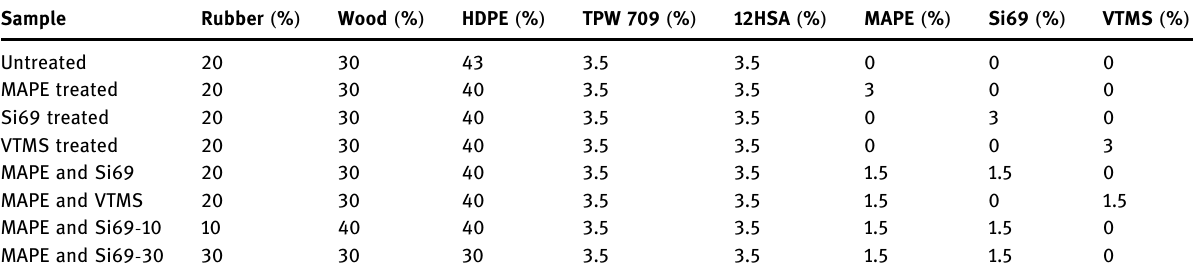
Table 1: Formulation of RubWPC